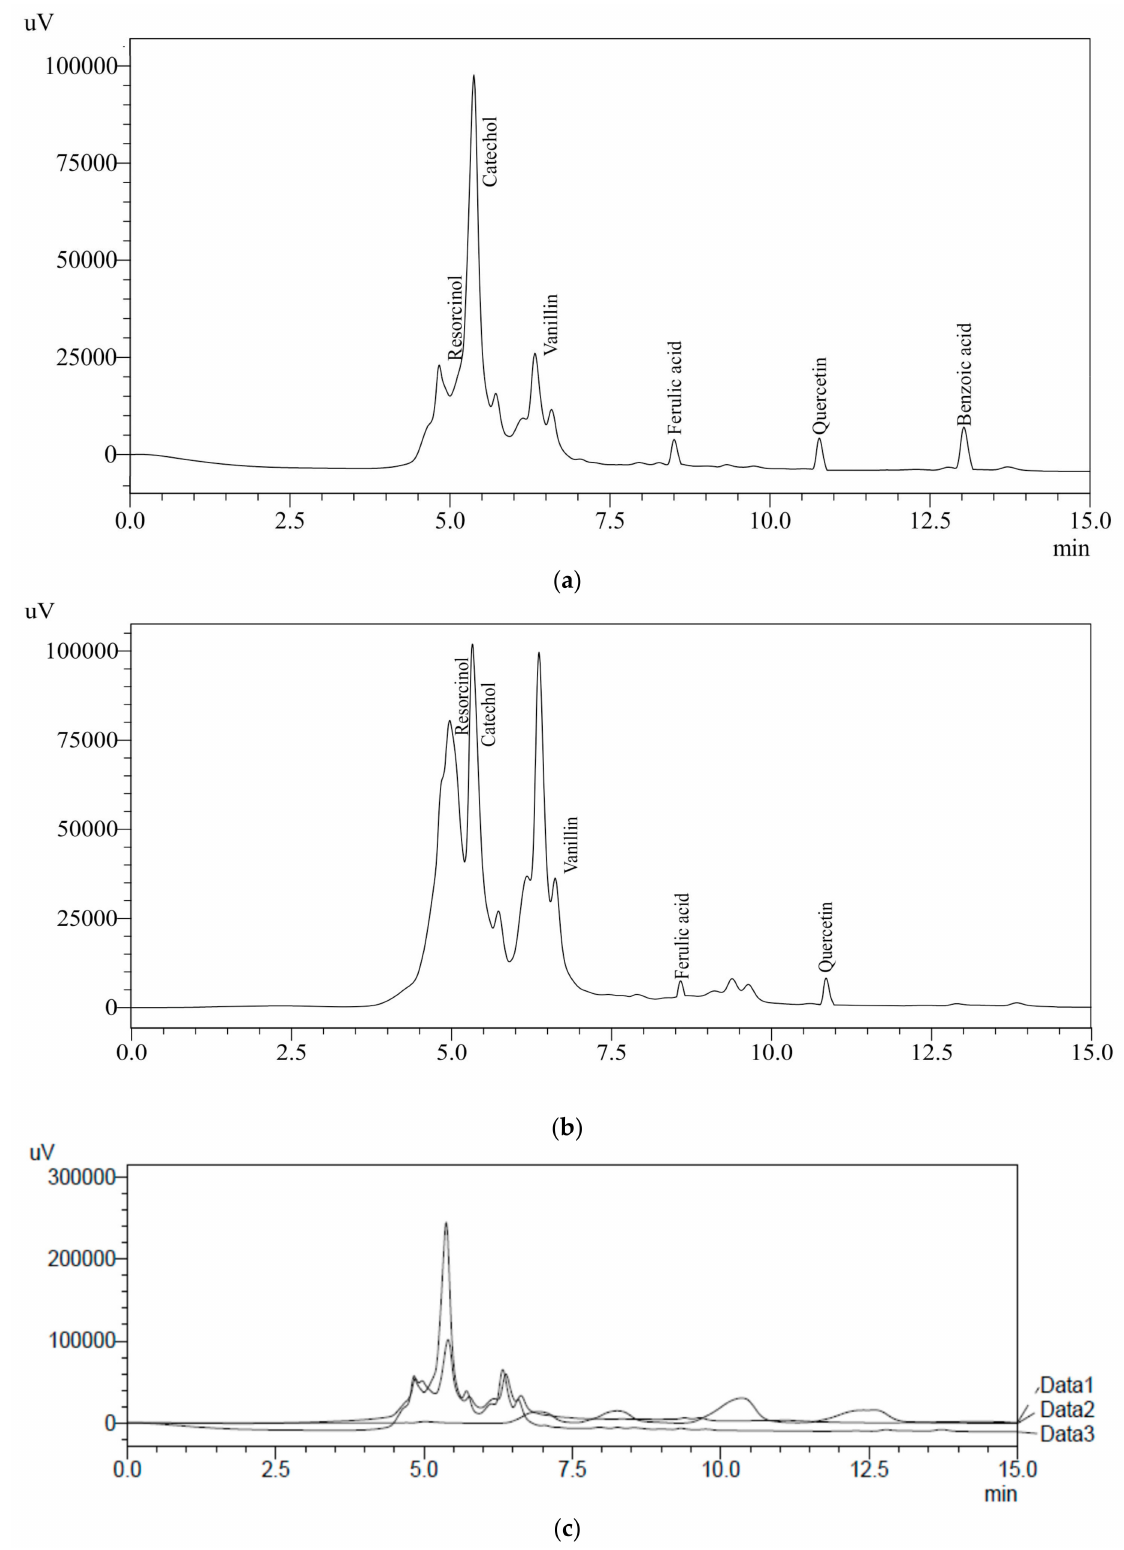
Figure 3. ( a ) HPLC chromatograph of BRE; ( b ) HPLC chromatograph of WRE; ( c ) overlay of HPLC standards with BRE and